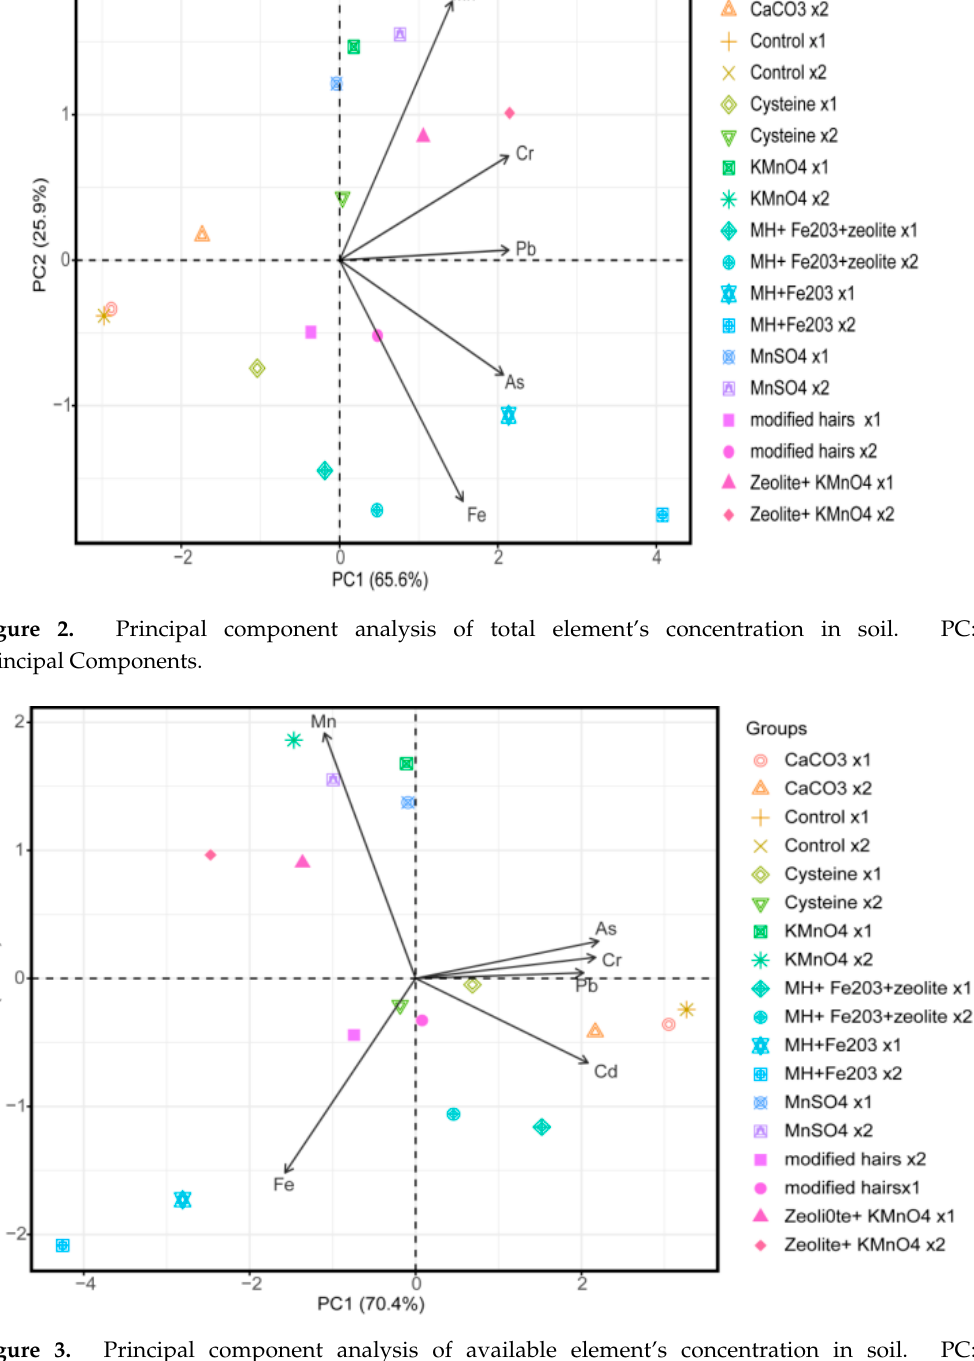
Figure 3. Principal component analysis of available element’s concentration in soil. PC: Principal Components.